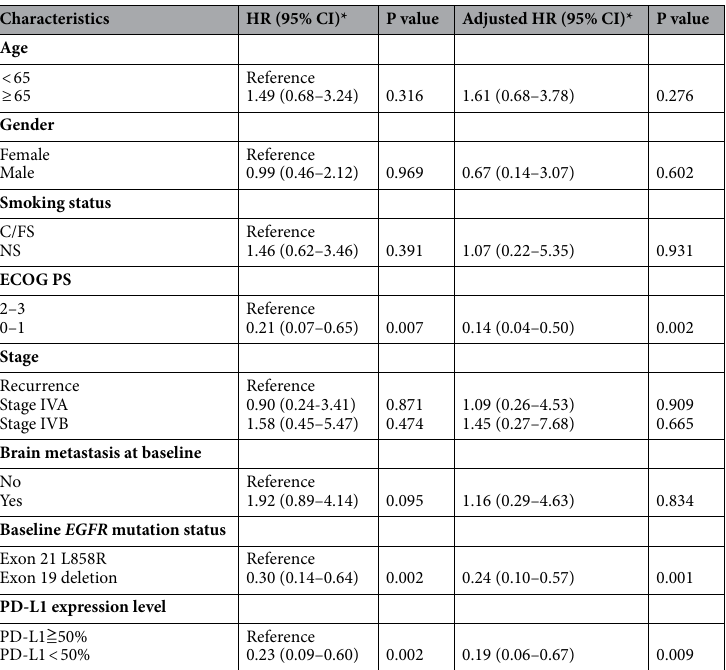
Table 2. Univariate and multivariate analyses of progression-free survival in NSCLC patients with osimertinib treatment (n = 71). NSCLC, non-small-cell lung cancer; HR, hazard ratio; CI, confidence interval; C/FS, current/former-smokers; NS, never smoker; ECOG PS, Eastern Cooperative Oncology Group performance status; EGFR, epidermal growth factor receptor; PD-L1, Programmed death-ligand 1. *By Cox proportional hazard model.